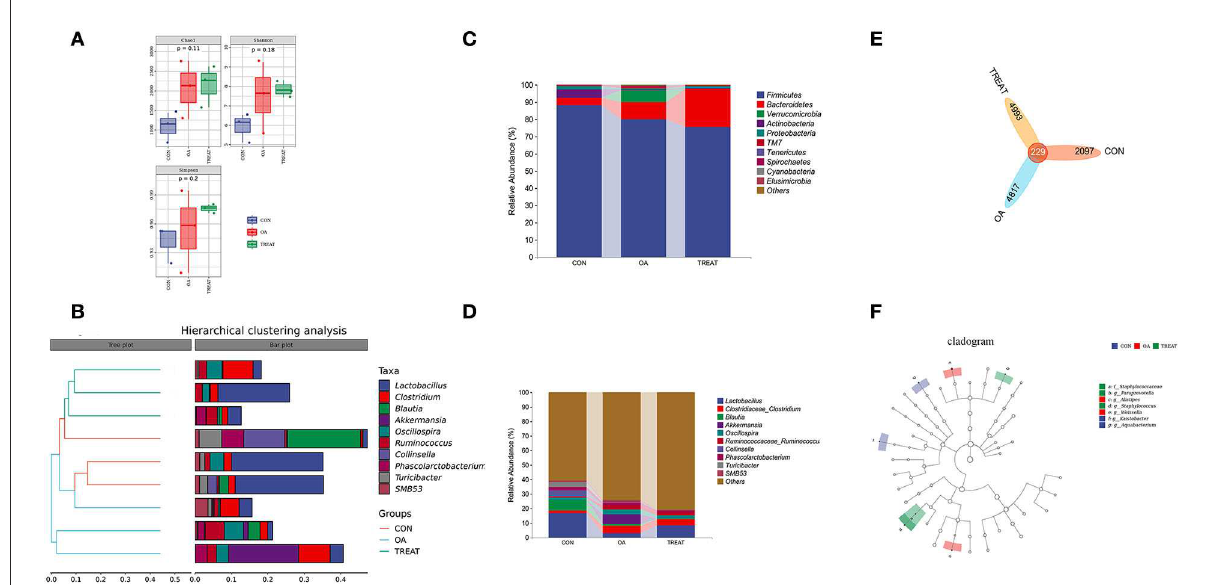
FIGURE3 Effects of the oral administration of live combined Bacillus subtilis and Enterococcus faecium on the fecal microbiota composition of OA rats. (A) α diversity. (B) Hierarchical clustering analysis. (C) Community bar plots of phylum level. (D) Community bar plots of the genus level. (E) Venn diagram demonstrates the overlaps among groups. (F) Taxonomic cladogram of LEfSe analysis ( n = 3).